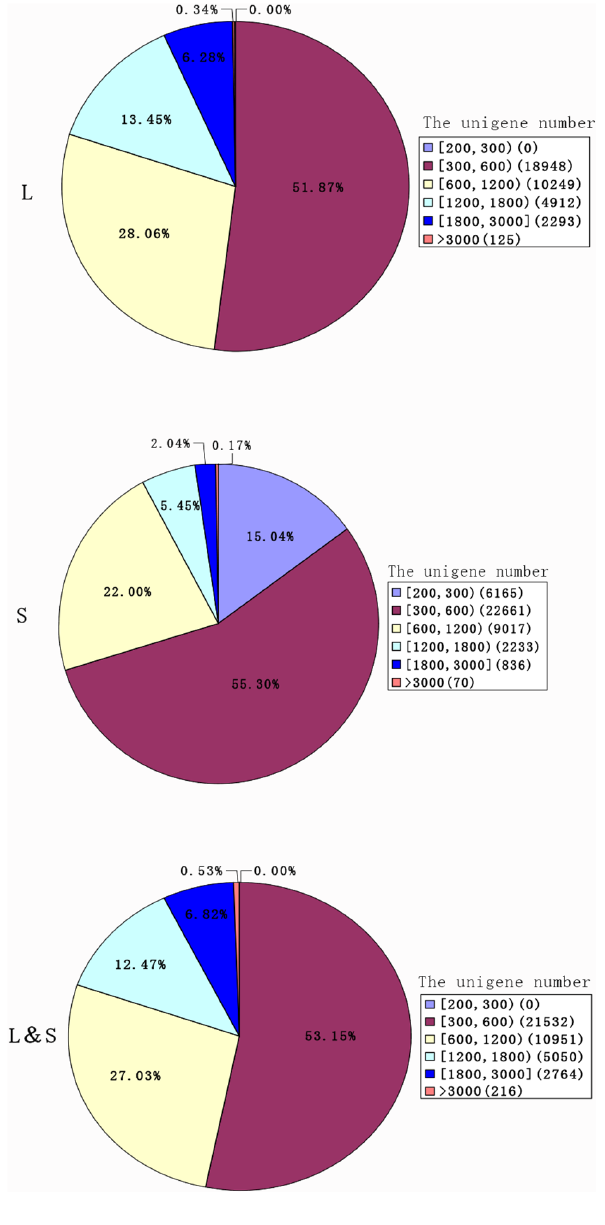
Figure 2. Length distribution of unigenes after de novo assembly using the reads from S, L and S&L libraries. Numbers in square brackets (e.g., [200, 300] and [1800, 3000]) indicate the range of unigene length, ‘ . 3000’indicates unigenes longer than 3,000 bp. Numbers in parentheses (e.g., (6, 165) and (22, 661)) indicate the total number of unigenes falling in this length range.